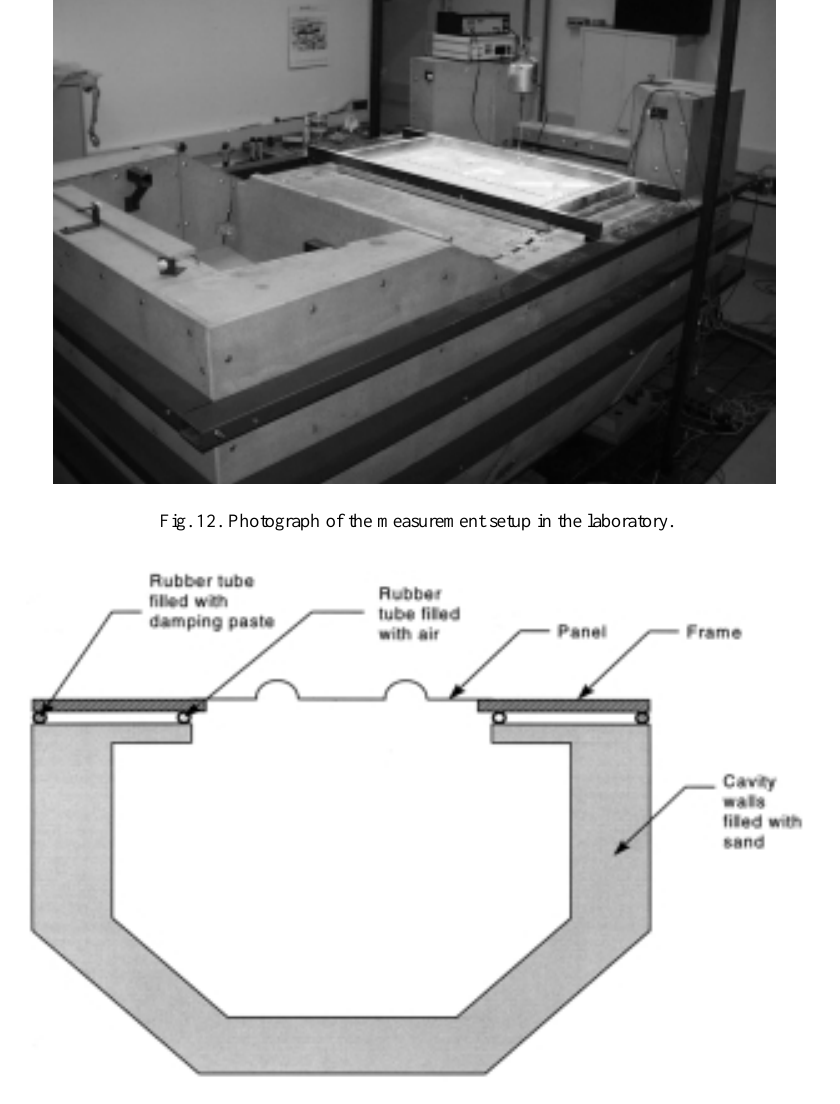
Fig. 13. Bearing and sealing of the